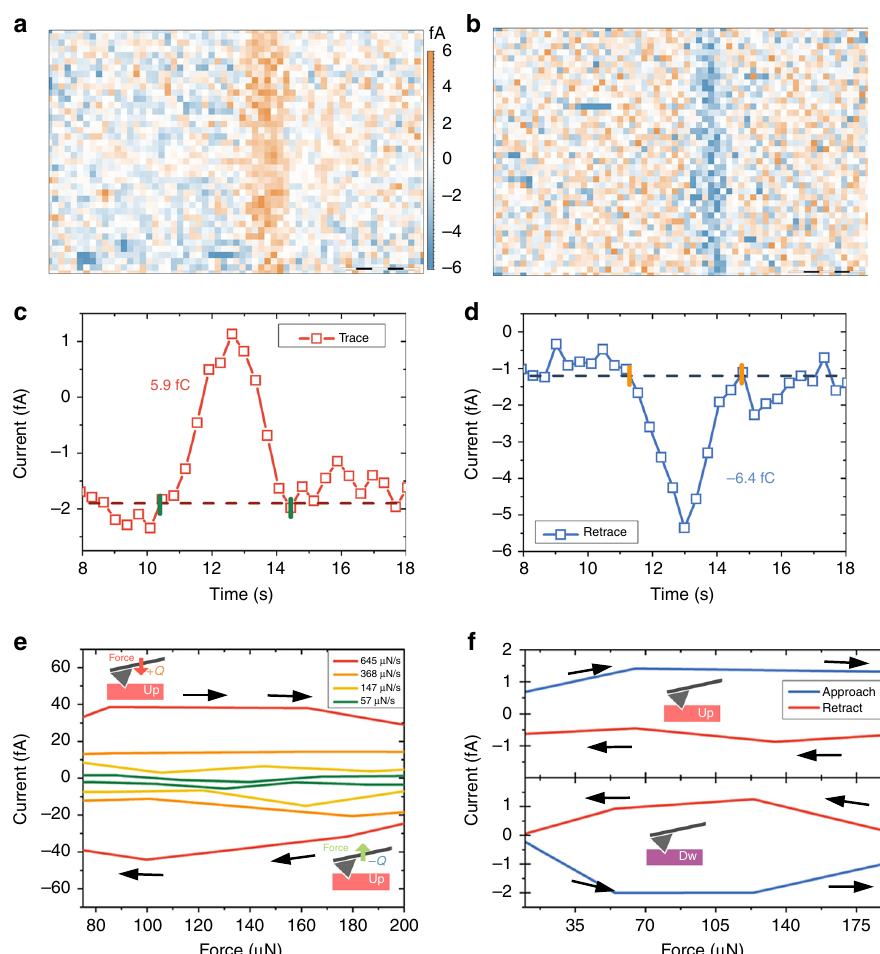
Fig. 4 Quantitative measurements and spectroscopy experiments. a DPFM-Si and b DPFM-So images of a zoomed region of the PPLN sample recorded in order to fully integrate the charge generated, scale bar 1 μ m. The mean pro fi le average from the images was obtained in order to reduce noise. The resulting pro fi les are plotted in c and d , which are directly integrated to estimate the generated charge. e current-vs-force spectroscopy sweep performed in the Up domain con fi guration, where different force sweep rates where applied. The current generated increases with the increasing force rate. Its sign is the opposite for approach-when force increases- and retract-when force decreases. f current-vs-force spectroscopy sweep for an Up domain (top) and a Down domain (bottom). For an Up domain increasing the force will generate a positive current while the opposite occurs for a Down